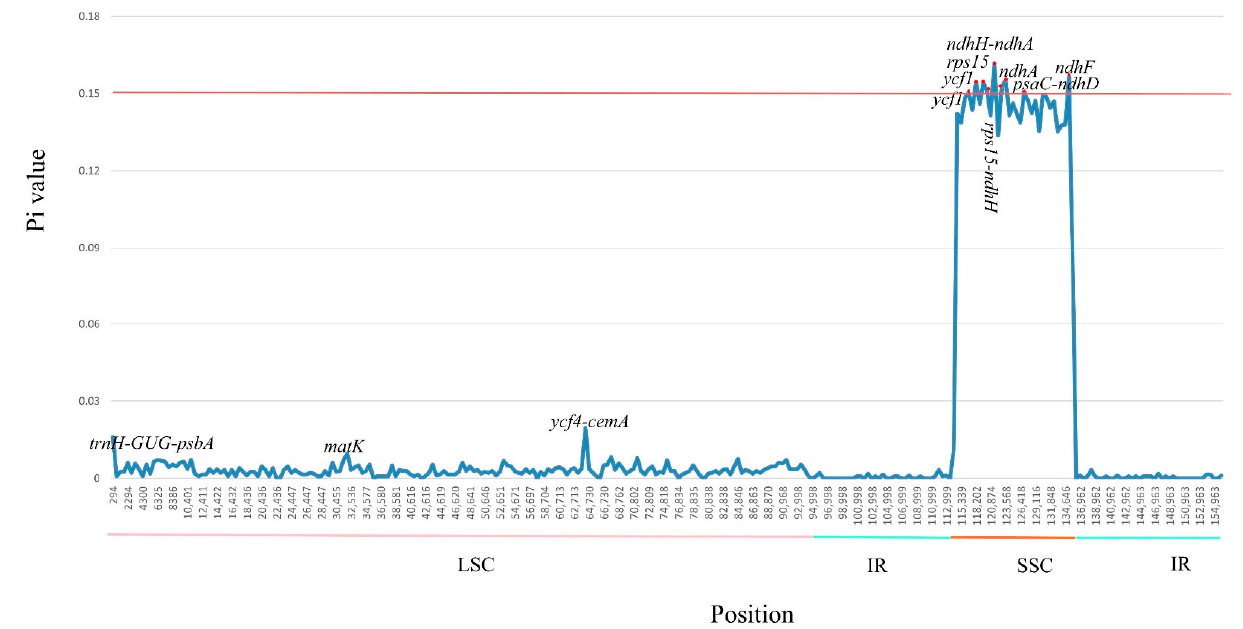
Figure 5. Comparison of the junction regions between LSC and IRb (JLB), LSC and IRa (JLA), IRa/IRb and SSC (JSA and JSB) among the chloroplast genome of five Machilus species. The LSC, IRa/IRb, and SSC regions are represented in light blue, orange, and green, respectively, in this map, while other colors represent genes on both sides of the boundary. The number above represents the distance in base pair between the ends of the genes and the boundary site (the distances in this graph are not plotted proportionally).